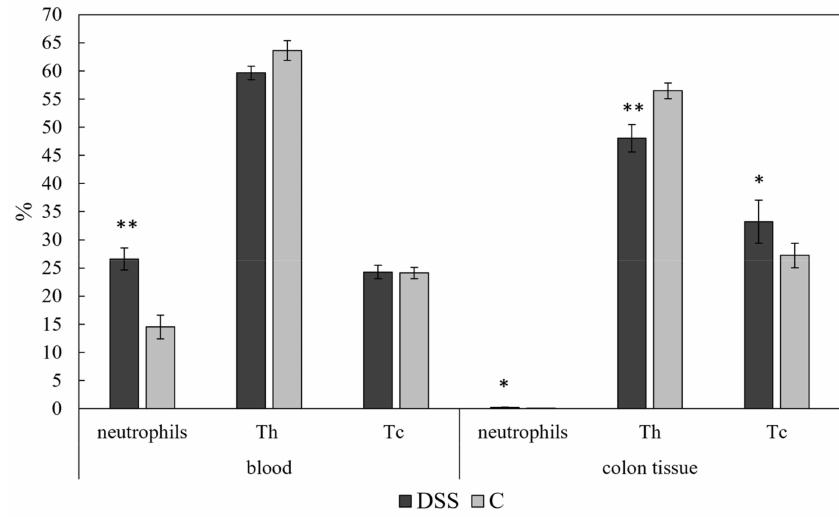
Figure 6. Immunophenotyping of blood and colon tissue immune cells. Data are shown as mean ± SEM ( n = 16/DSS group; n = 6/C group); (* p < 0.05; ** p < 0.01). DSS, induced colitis; C, healthy control. Th, helper T lymphocytes; Tc, cytotoxic T lymphocytes.